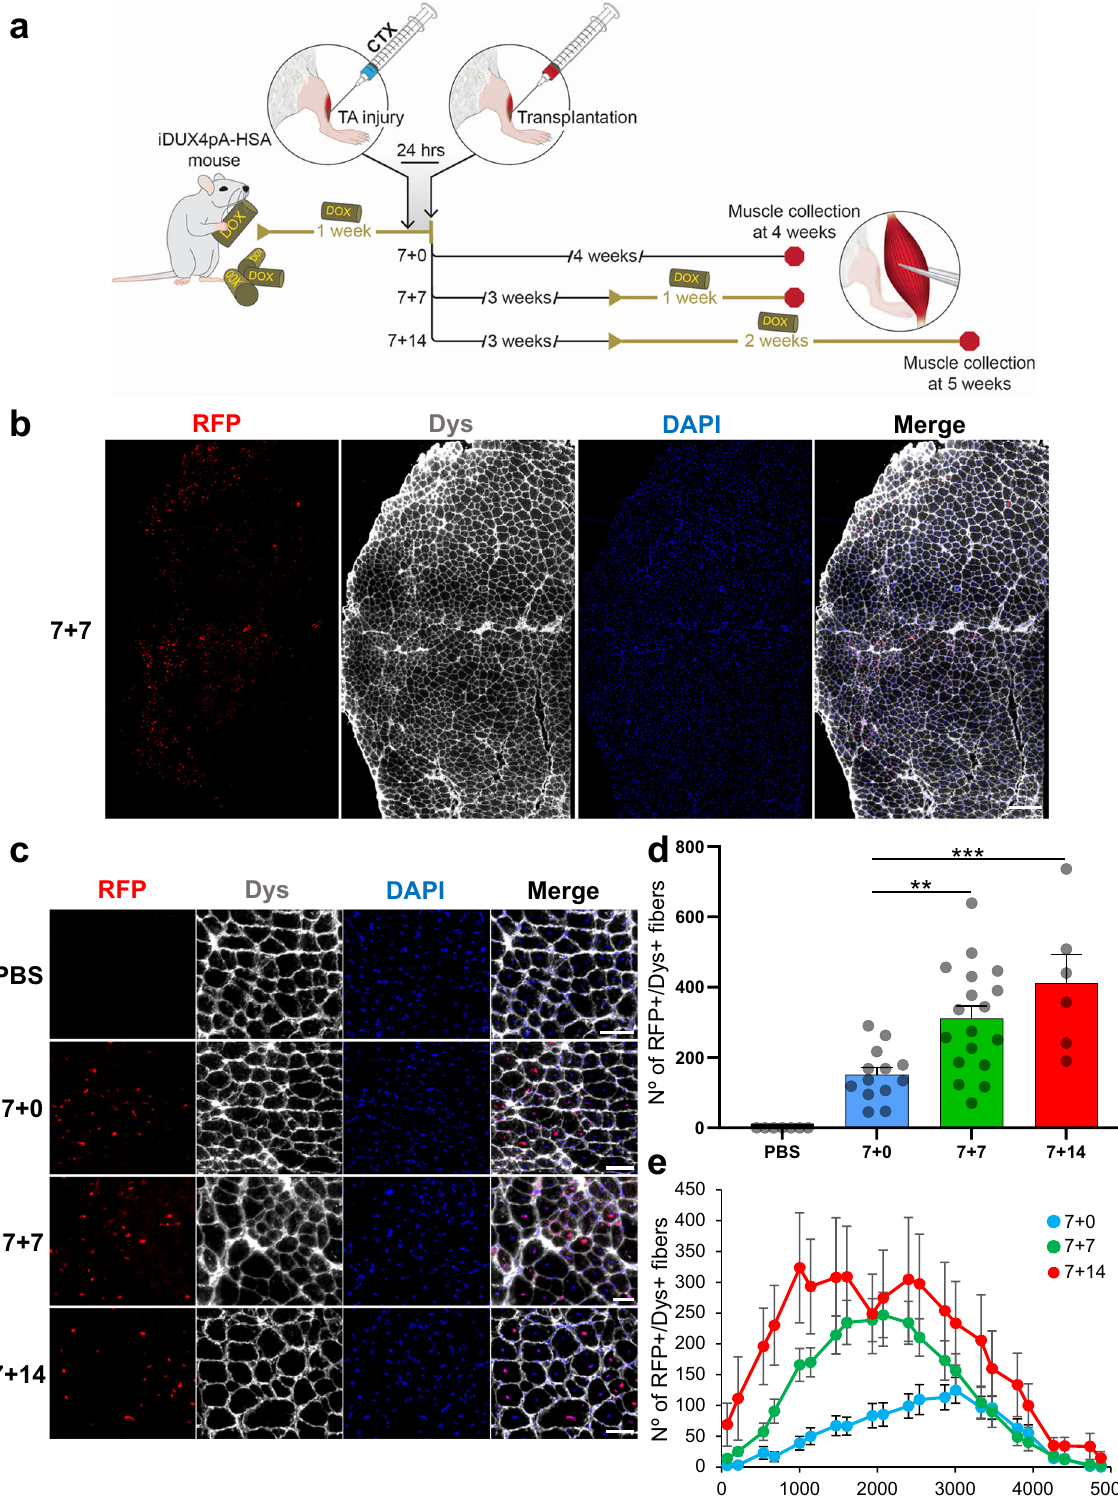
Fig. 2 Engraftment is persistent even in the context of bursts of DUX4 expression. a Outline of experimental design. b Representative images, capturing the complete engrafted area, show immunostaining for RFP (in red), Dys (in gray), and DAPI (in blue) of the 7 + 7 cohort. Scale bar is 200 µm. c Representative images show the same staining as b for the 3 experimental groups depicted in a : 7 + 0, 7 + 7, and 7 + 14. Upper panel shows PBS-injected control. Scale bar is 50 µm. d Graph shows quanti fi cation of engraftment (from c ) as shown by the number of donor-derived RFP + /Dys + myo fi bers. Data are shown as mean ± SEM ( n = 7 for PBS, n = 13 for 7 + 0, n = 18 for 7 + 7 and n = 6 for 7 + 14). ** p < 0.01, *** p < 0.001 by the Student ’ s t test. e Distribution of the number of RFP + /Dys + myo fi bers along the TA muscle. Data are shown as mean ± SEM ( n = 13 for 7 + 0, n = 18 for 7 + 7, and n = 6 for 7 +